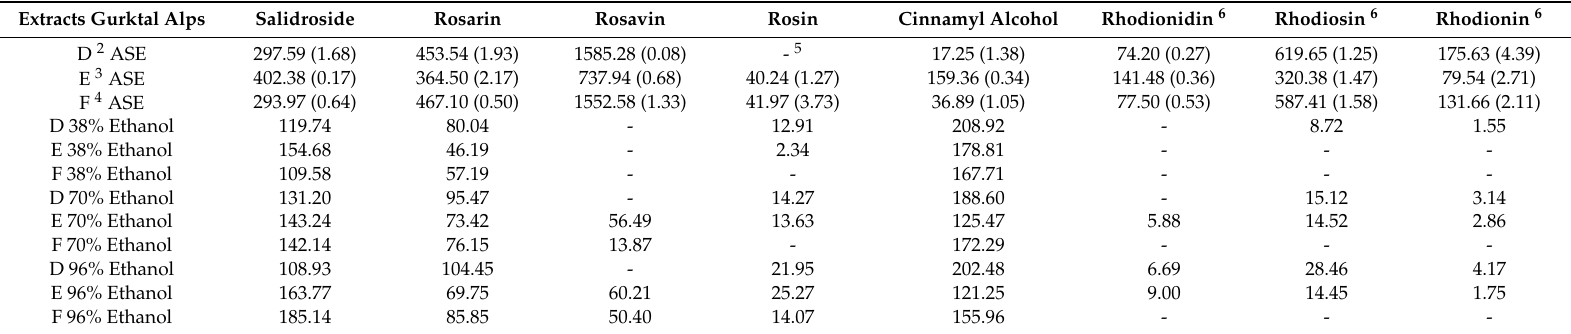
Table 6. Quantitative analysis of Rhodiola rosea rhizome extracts from collection site Gurktal Alps (mg / 100 g plant material 1 ). Extracts Gurktal